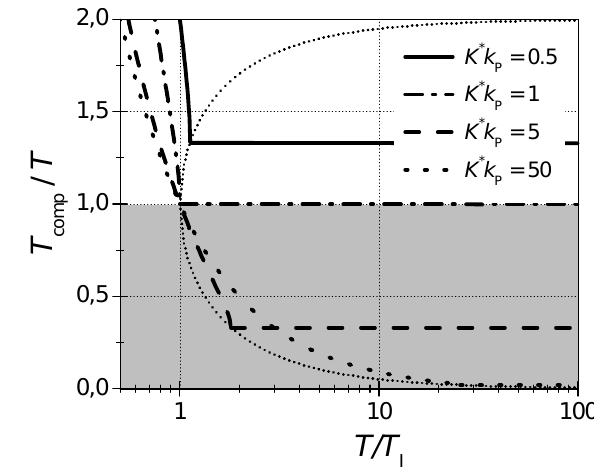
Figure 18. Normalized response time of the closed-loop PT 1 -type sensor using a PI-controller versus integral time. The gray region indicates where a response time reduction is